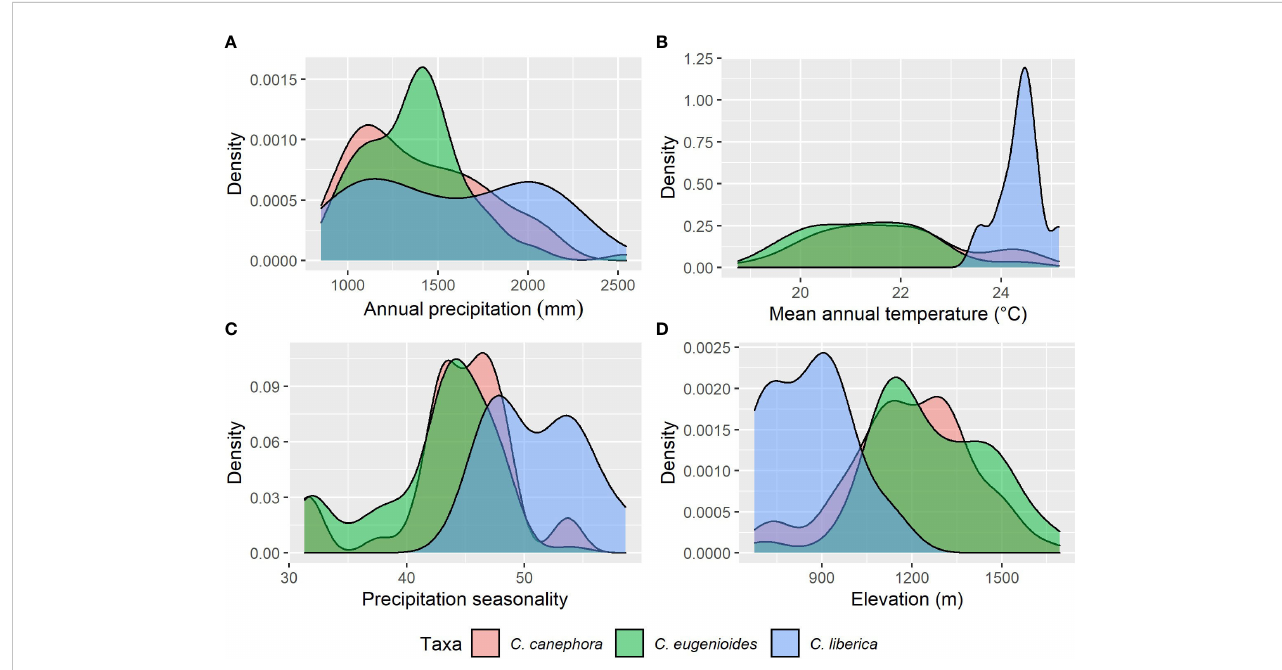
FIGURE 3 Density plots based for key climate variables and elevation (see Methods) for C. canephora , C. eugenioides , and C. liberica var. dewevrei . (A) total mean annual precipitation (mm year) from CHELSA Bio1; (B) mean annual temperature (°C) from CHELSA Bio12; (C) precipitation seasonality from CHELSA Bio15; (D) elevation (m). Summary statistics: (mean values in parentheses): C. canephora (21.8°C/1,389 mm/44/1187 m); C. eugenioides (21.3°C/1,370 mm/42/1261 m); and C. liberica var. dewevrei (24.4°C/1,560 mm/51/857 m). See Table